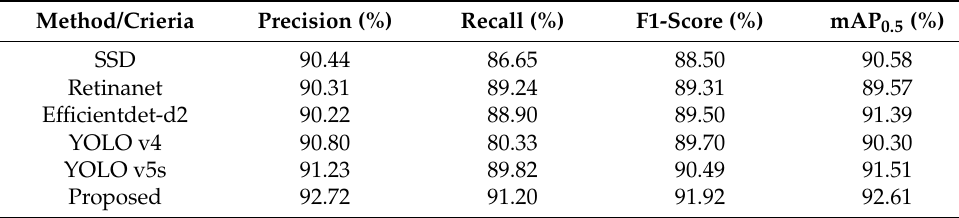
Table 2. Results of the overall dataset comparison.